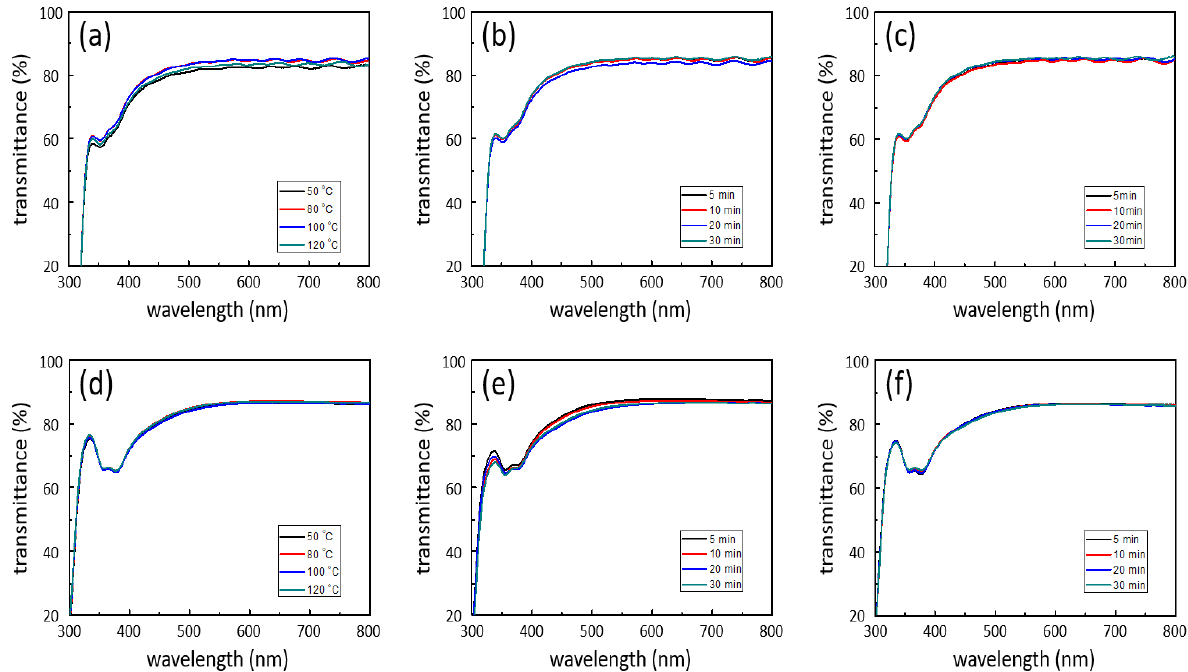
Figure 5. Optical transmittance of ( a – c ) the AgNW-exposed electrodes and ( d – f ) the AgNW- embedded electrodes dried by different methods against the drying temperature and time: ( a , d ) thermal drying, ( b , e ) room-temperature drying, and ( c , f ) vacuum drying.